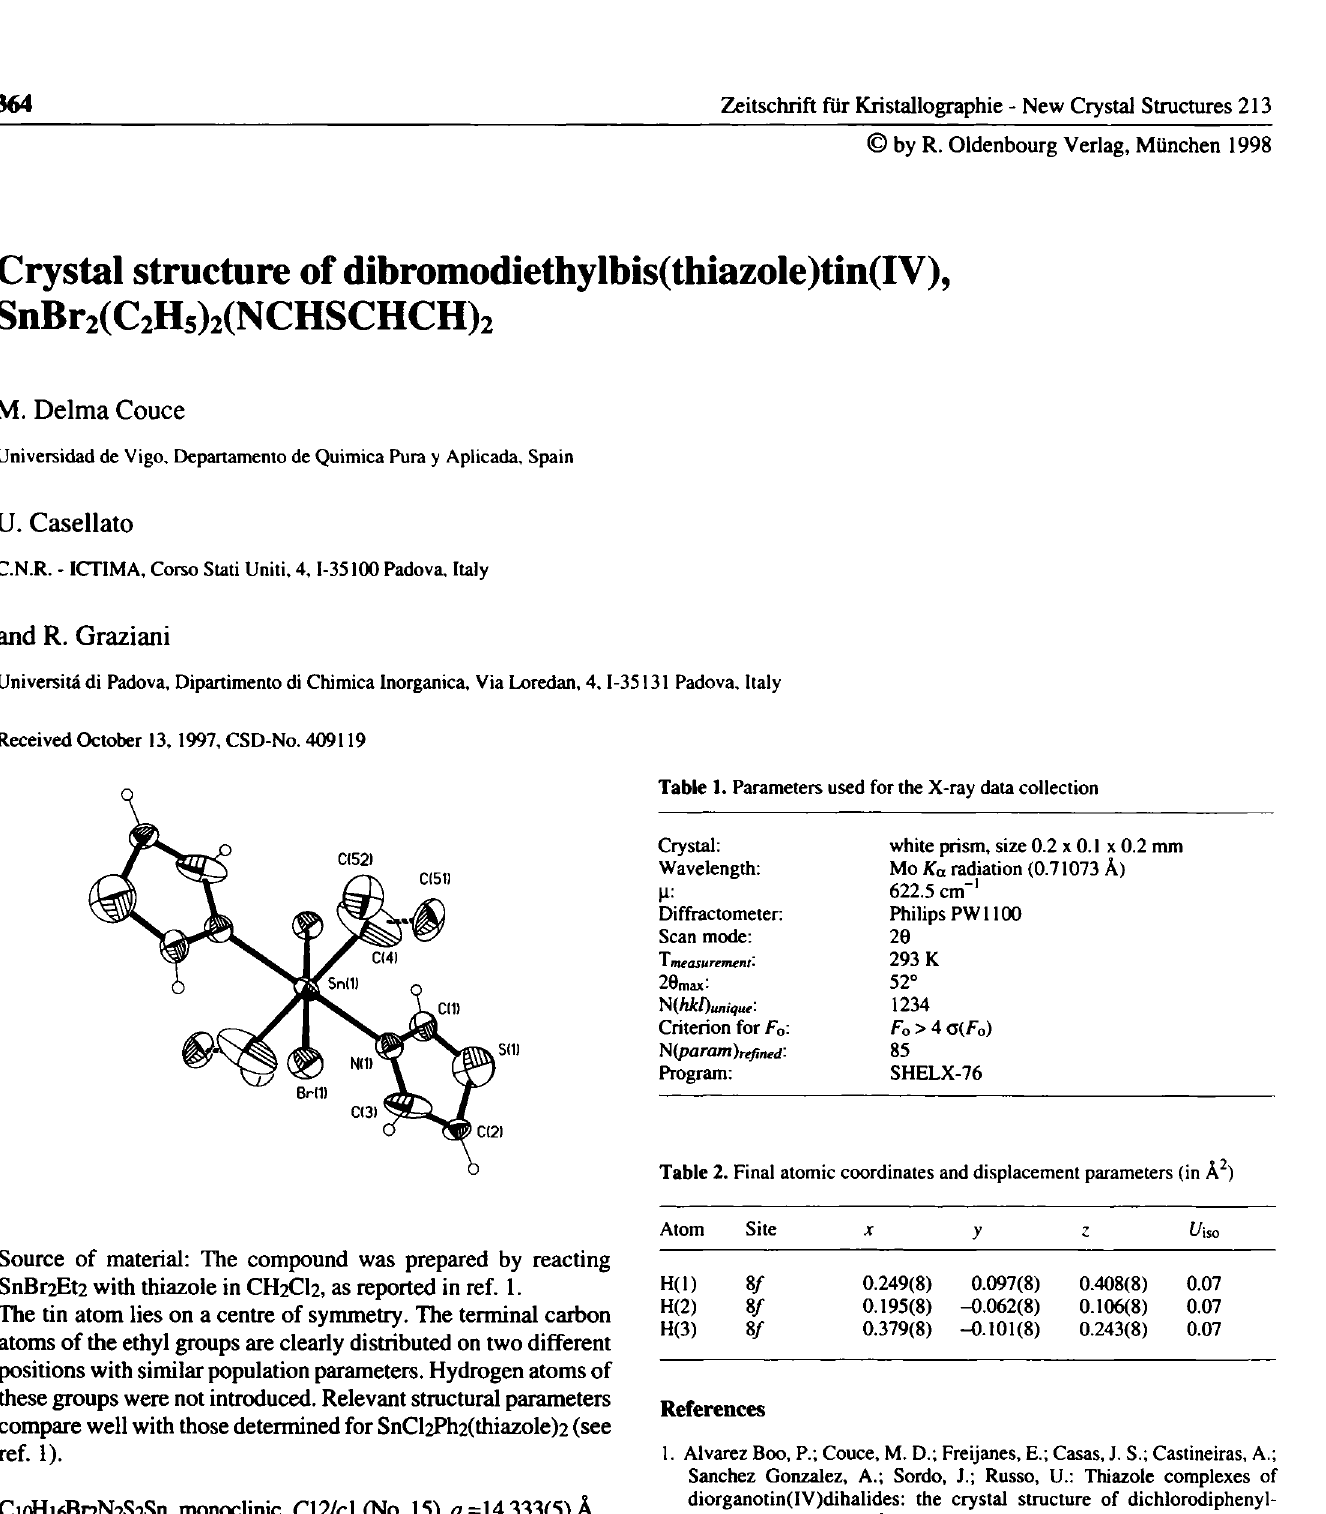
Table 3. Final atomic coordinates and displacement parameters (in À^)